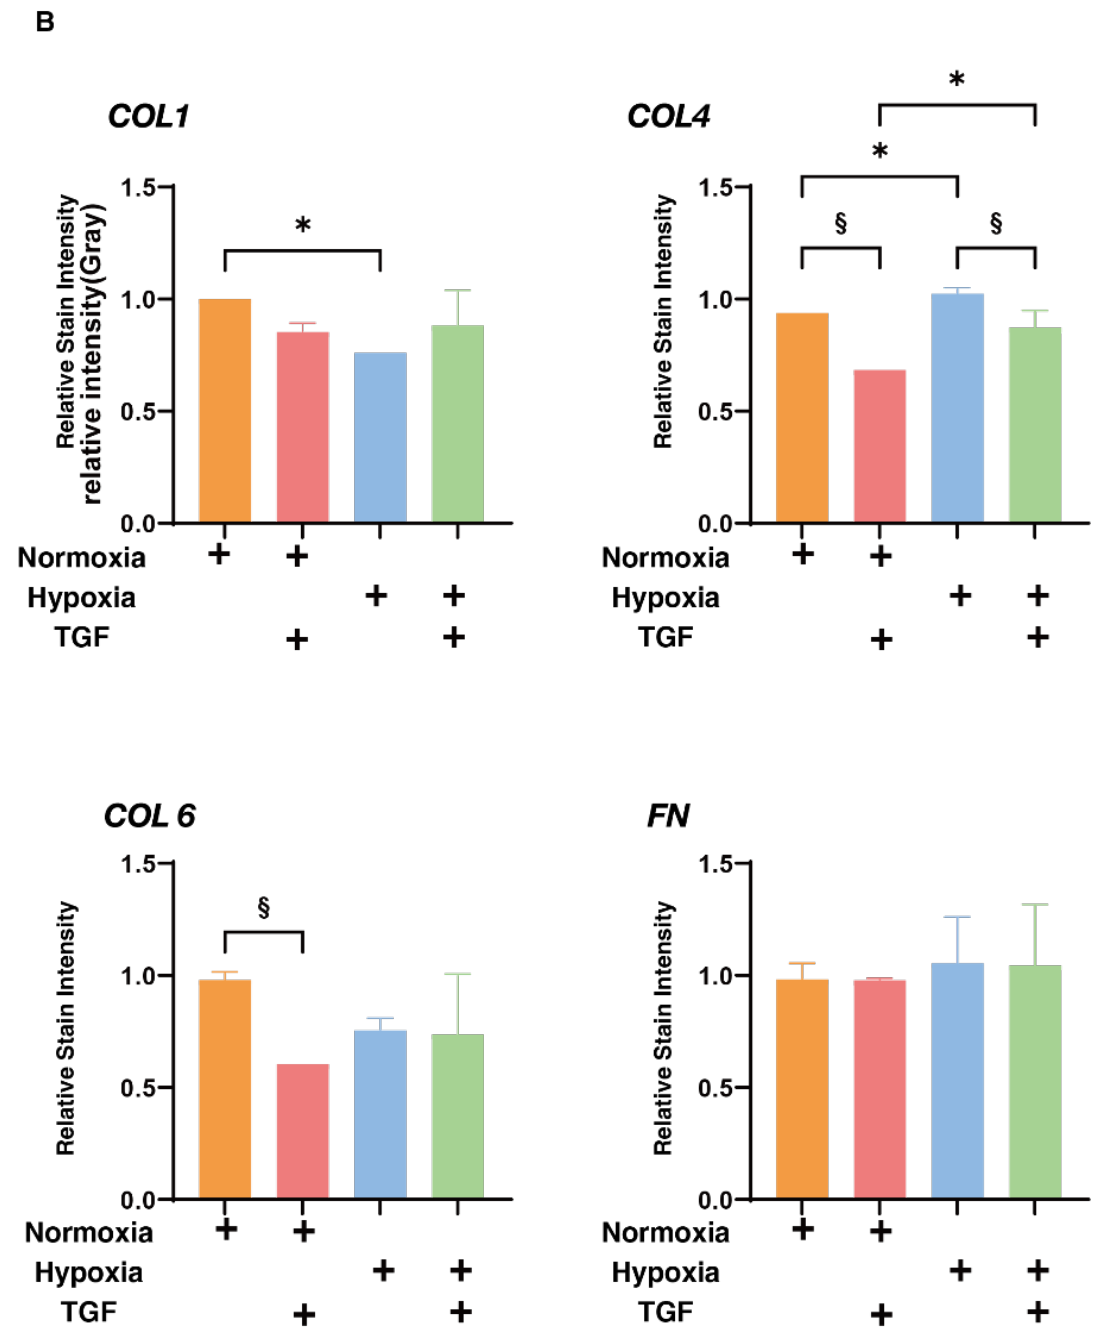
Figure 6. Immunolabeling of ECMs of the 3D HRPE spheroids under normoxia or hypoxia conditions. Three-dimensional HRPE spheroids at Day 6 prepared under normoxia or hypoxia conditions were treated without (control) and with a 5 ng/mL solution of TGF- β 2 (TGF), and each sample was then subjected to immunostaining for COL1 , COL4 , COL6 , and FN . All experiments were performed in duplicate using fresh preparations (n = 5 spheroids each). Representative images (upper; merged with DAPI, lower; anti-ECM, scale bar; 100 µ m) are shown in panel A and relative staining intensities against the normoxia conditions without TGF- β 2 were plotted in panel B. “+” is reagents addition. Data are presented as the arithmetic mean ± standard error of the mean (SEM). * p < 0.05 control vs. TGF, § p < 0.05 normoxia vs. hypoxia (ANOVA followed by a Tukey’s multiple comparison test).